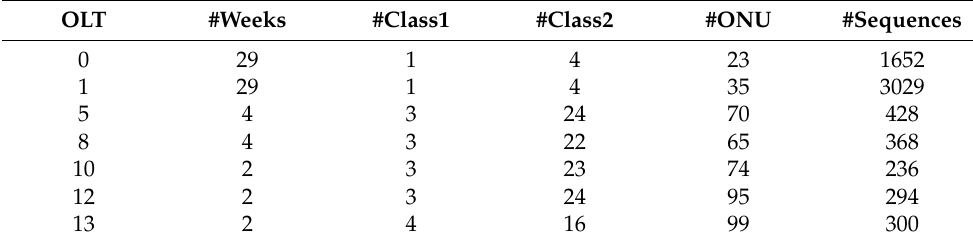
Figure 9. Ground truth topology of OLT 0 and OLT 1. ( a ) OLT 0. ( b ) OLT 1. Table 1. OLTs in our experiments.